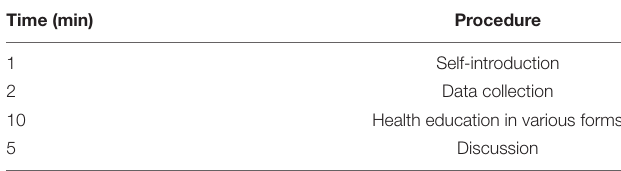
TABLE 3 | Procedures of pre-operative health education.